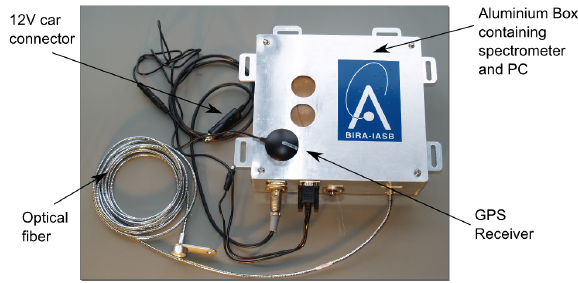
Fig. 2. The ULM-DOAS instrument. Inside the box are a compact UV-Vis spectrometer and a PC-104. Light is collected directly by the optical fiber and a GPS is used to geolocalize the measurements. The whole system is powered with 12V.